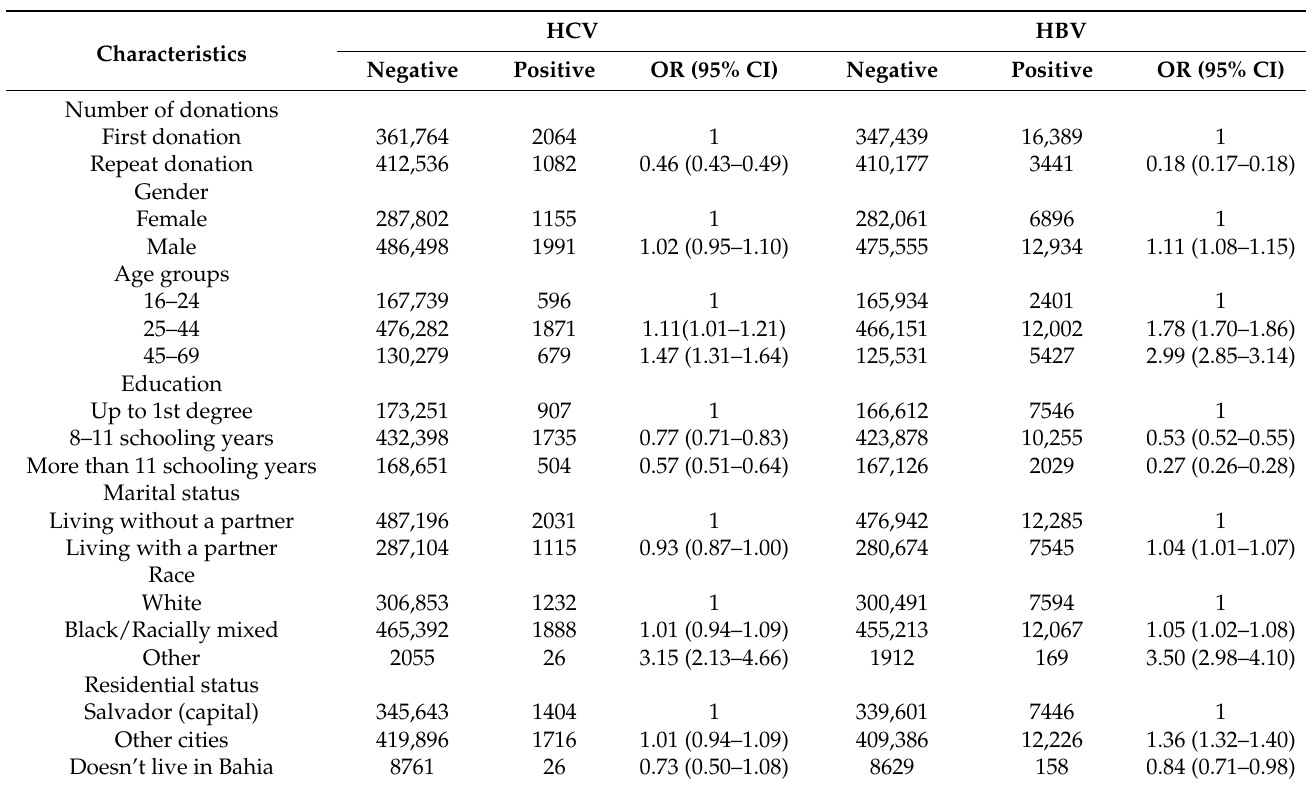
Table 5. Bivariate analysis of demographic characteristics associated with HCV and HBV’s infections among Hemoba blood donors from February 2008 to December 2017.